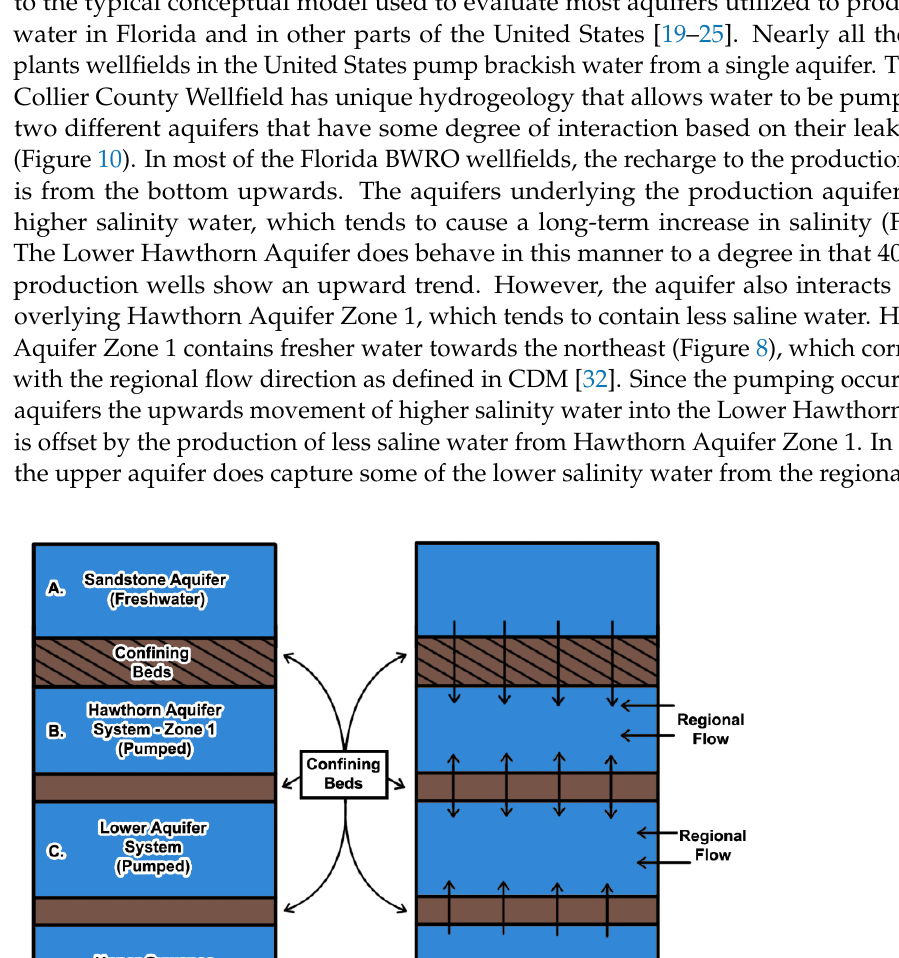
57005950620064506700695072007450770079508200845087008950920094509700995010200 Figure 11. Conductivity of the feed water for 2019 and 2020. The mean is near 9400 millisiemens, which is an estimated TDS of 4700 mg/L or a dissolved chloride value of about 2585 mg/L. J a nu a r y